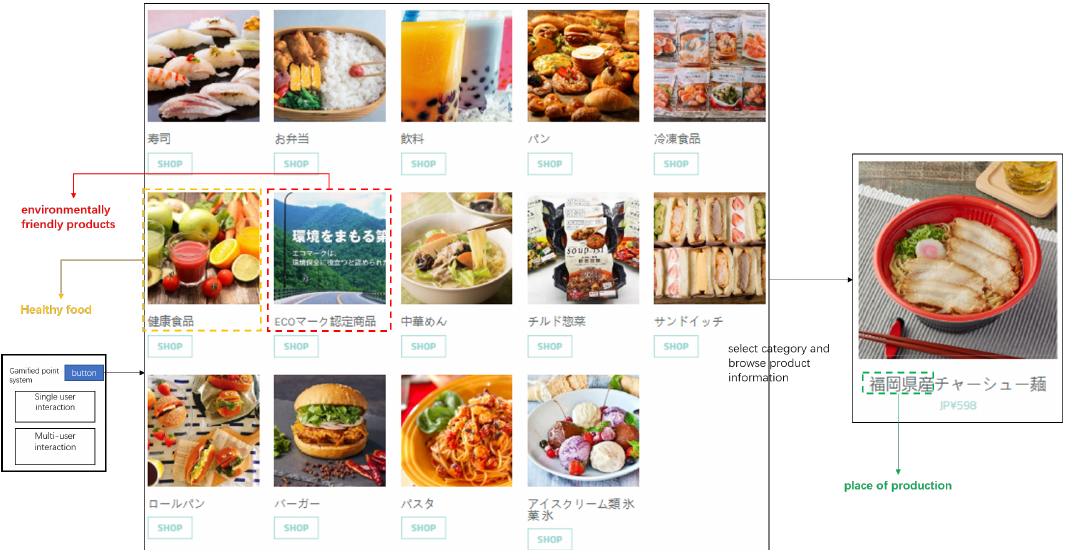
Figure 6. Online shopping experiment process. Users access shopping websites through links built in the gamified point system. The shopping website contains 14 categories of products. After entering the sub-interface, the user can view specific product information and then select the product to purchase. The figure shows the level 1 interface of the website and the name of one product in the level 2 interface. Categories include sushi, bento, drinks and more. The right side shows noodles produced in Fukuoka